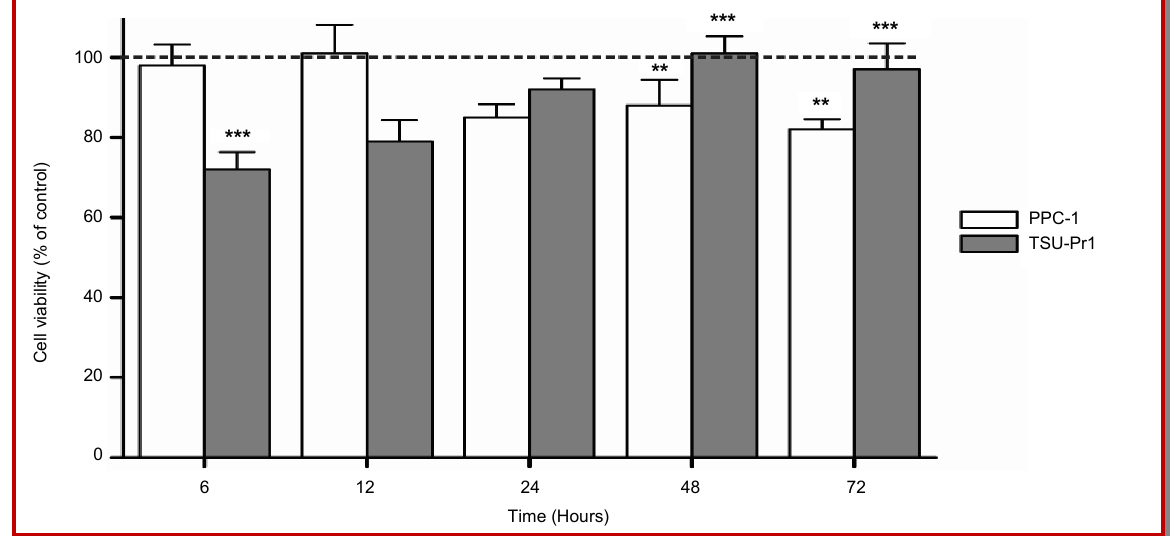
Figure 1: Number of PPC-1 and TSU-Pr1 viable cells after treatment with axitinib and dasatinib (20 mM) for 6 to 72 hours. Results are expressed as % of control (dashed line). Error bars indicate mean ± S.E.M